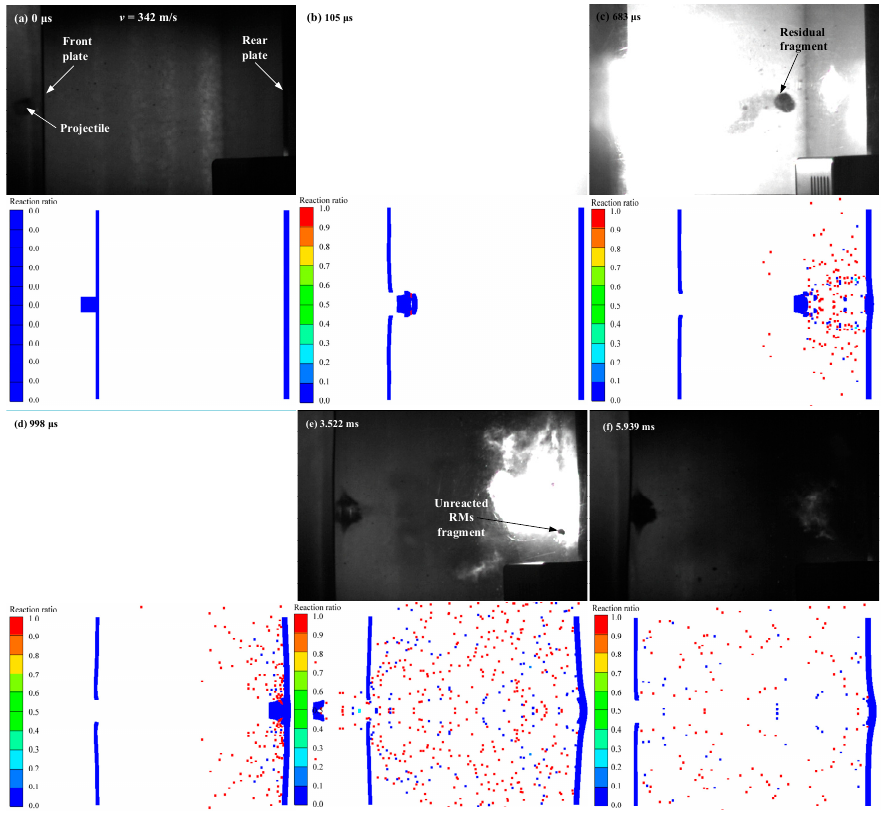
Figure 5. The impact-induced deflagration behavior of RMP with a velocity of 342 m/s.